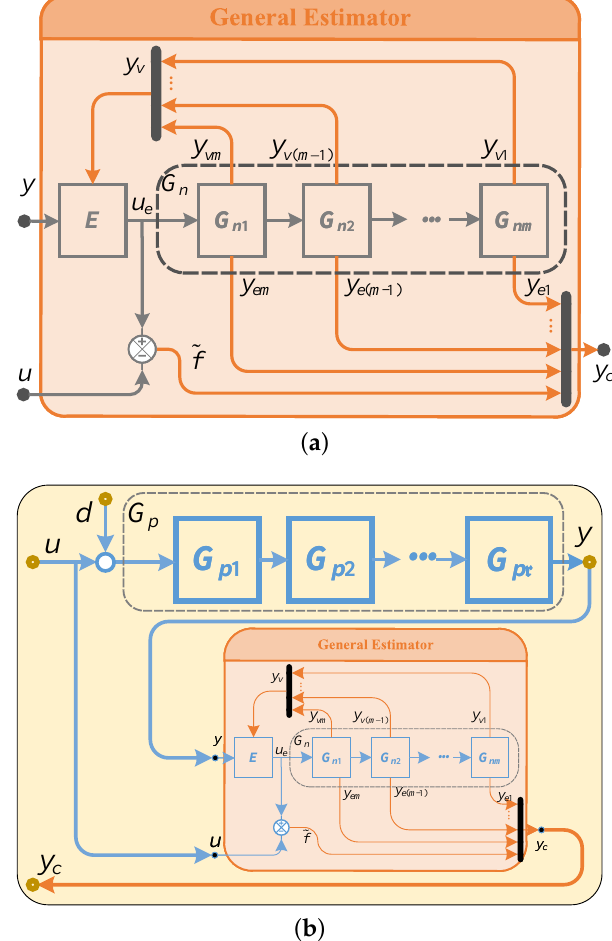
Figure 2. General estimator block diagrams: ( a ) the structure of the generalized inverse solver; ( b ) GIS in the closed